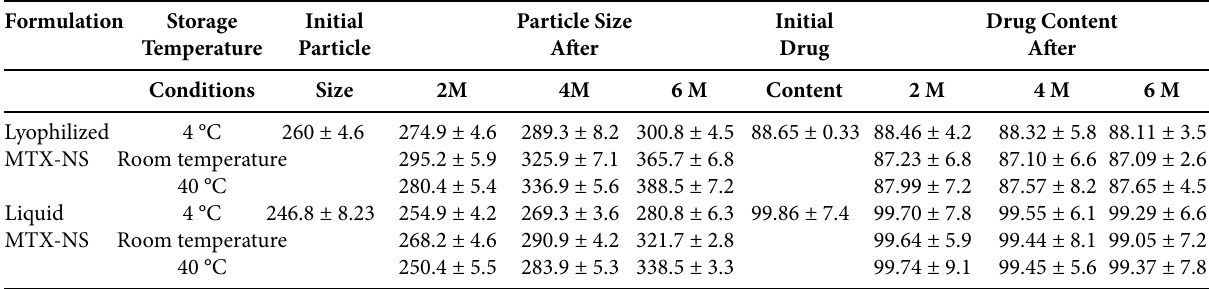
Table 8. Physical stability data of lyophilized and liquid MTX-NS